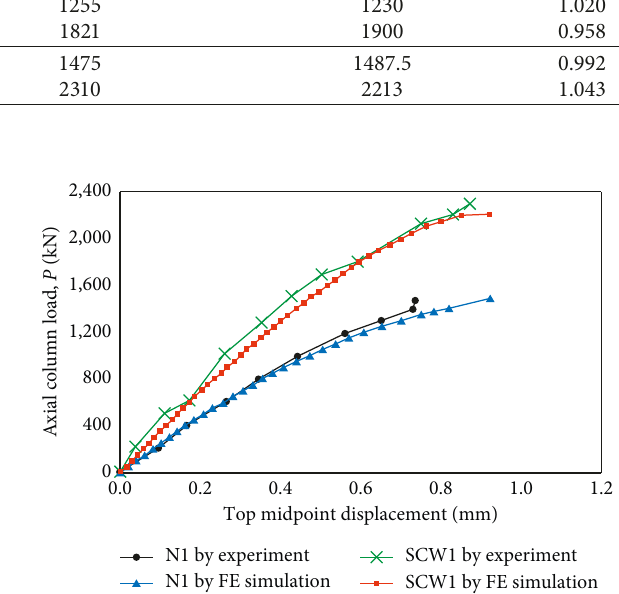
Figure 4: Curves showing displacement of load gained from both experimental Tarabia and Albakry [4] and FE